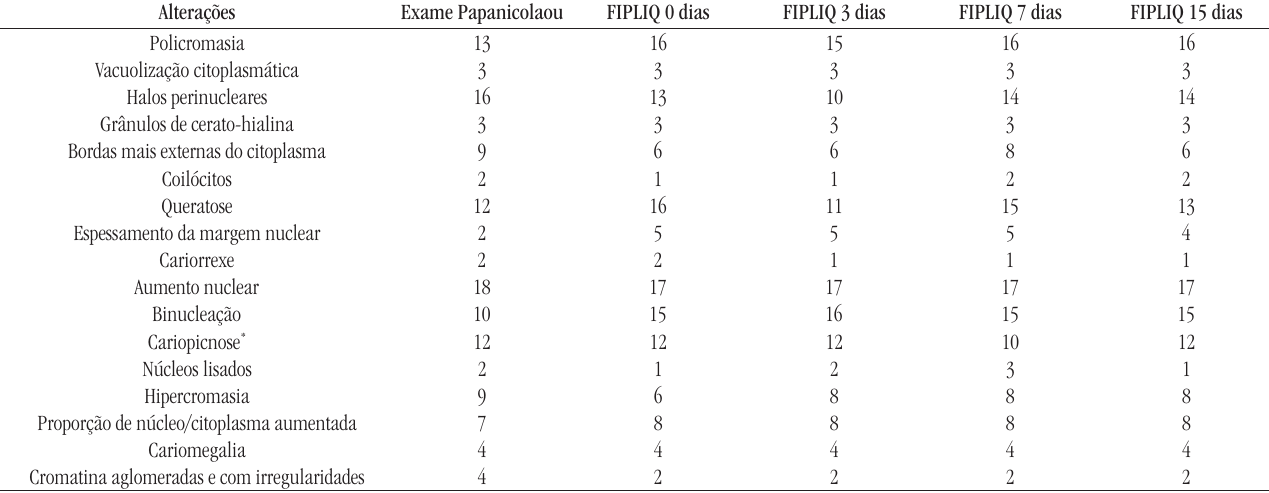
FIPLIQ: fosfato de formaldeído-isopropanol; * presença de cariopicnose, exceto em células superficiais.